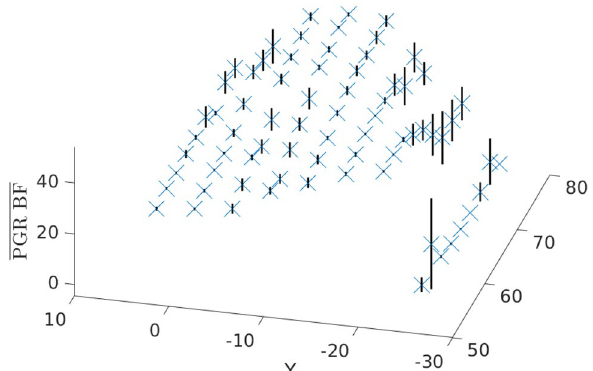
Fig. 11 PGR ( 𝐩 i ) and PGR s ( 𝐩 i ) , where poses consider only variations in the X-Y plane, so 𝐩 i ∈ ℝ 2